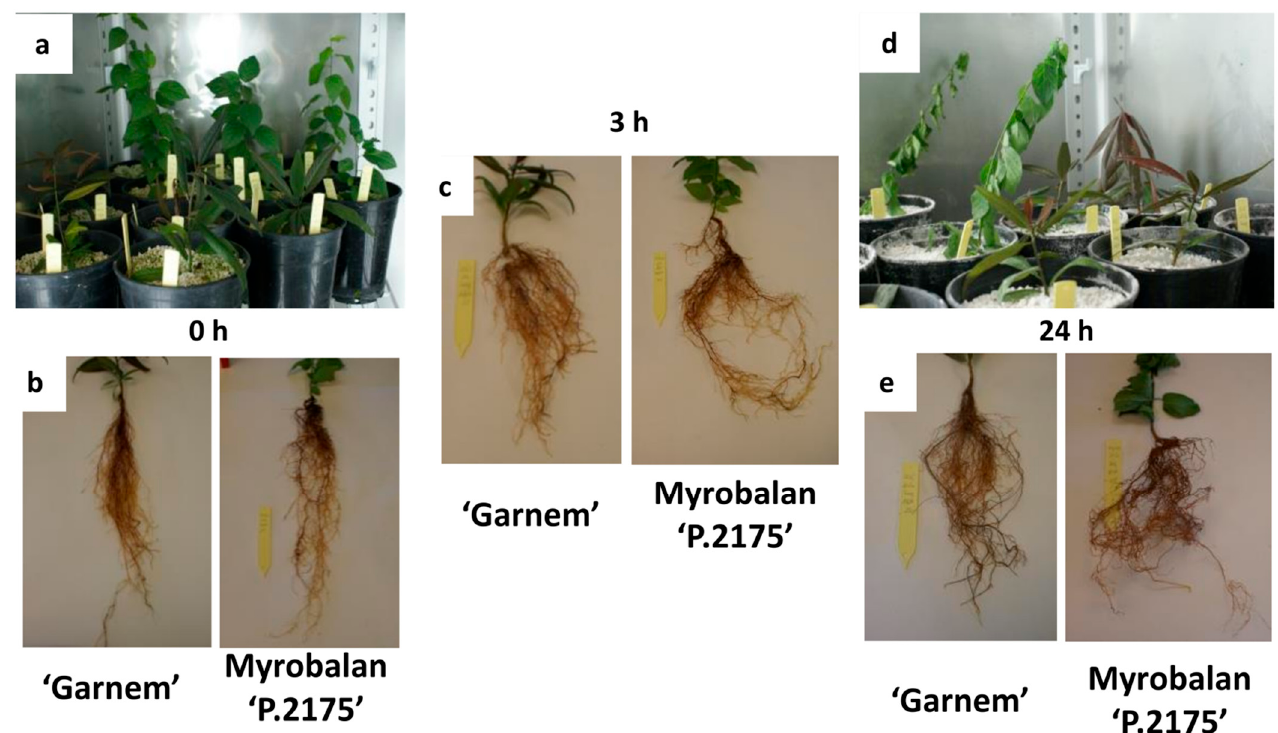
Figure 1. Representative images of the water status of the stressed plants of the studied genotypes (‘Garnem’ and Myrobalan ‘P.2175’) throughout the drought experiment for each time-point: ( a ) aerial part and ( b ) roots at 0 h; ( c ) rooted parts at 3 h; and ( d ) aerial part and ( e ) roots at 24 h.